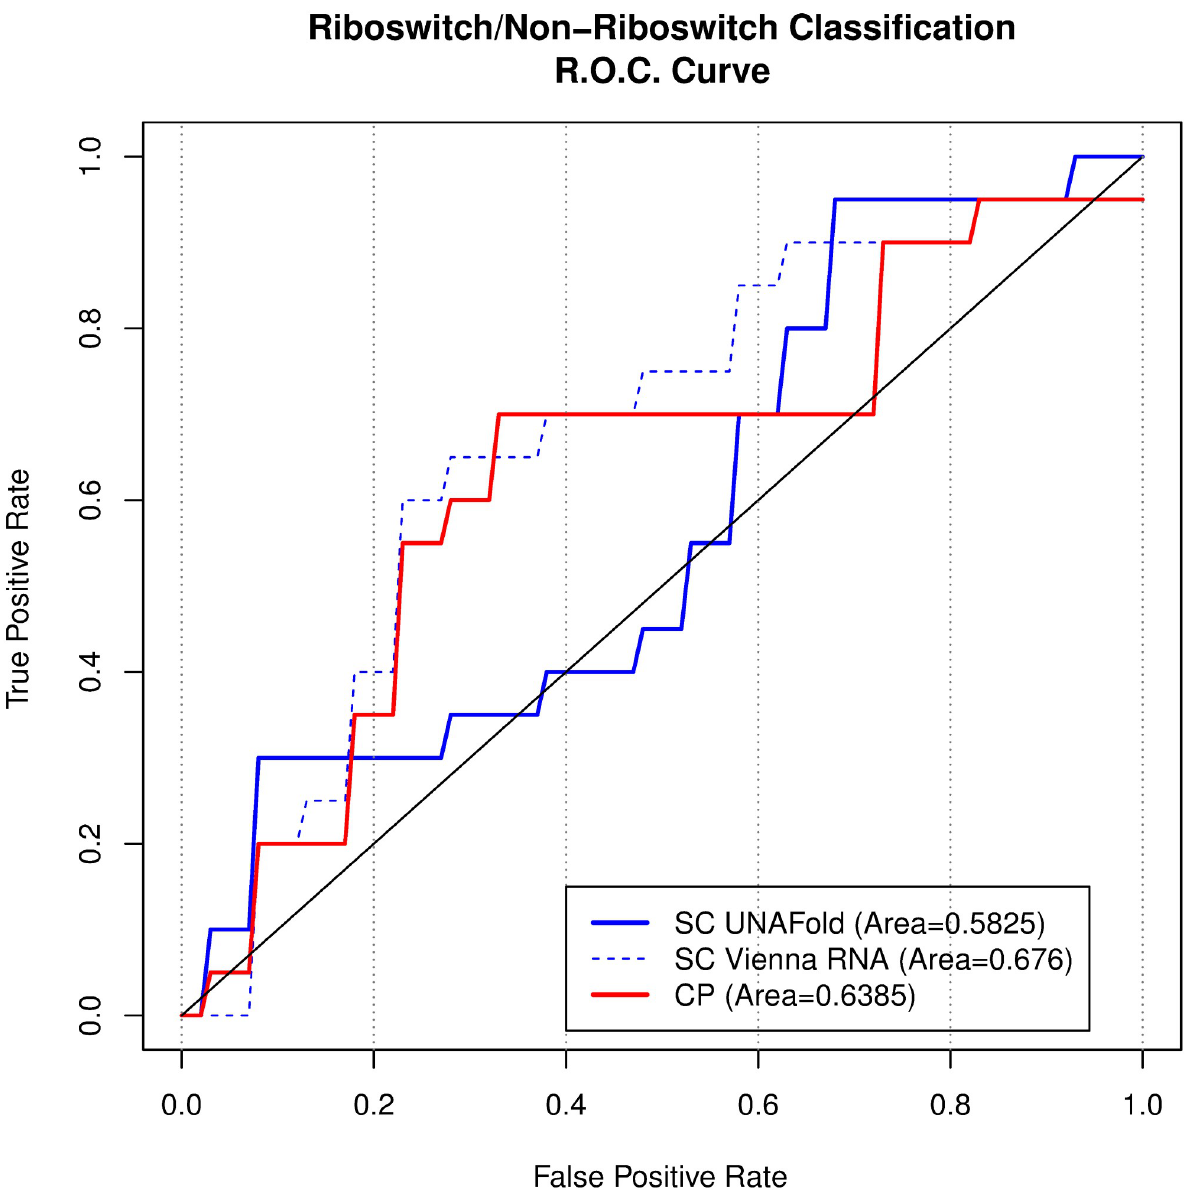
Fig 4. ROC. curves for SC- and CP-based riboswitch classifiers. The blue and red lines correspond to SC- and CP-based classifiers. The legend gives the ROC value, the area under the curves for the two classification methods. Calculations were done at 37˚C for all three